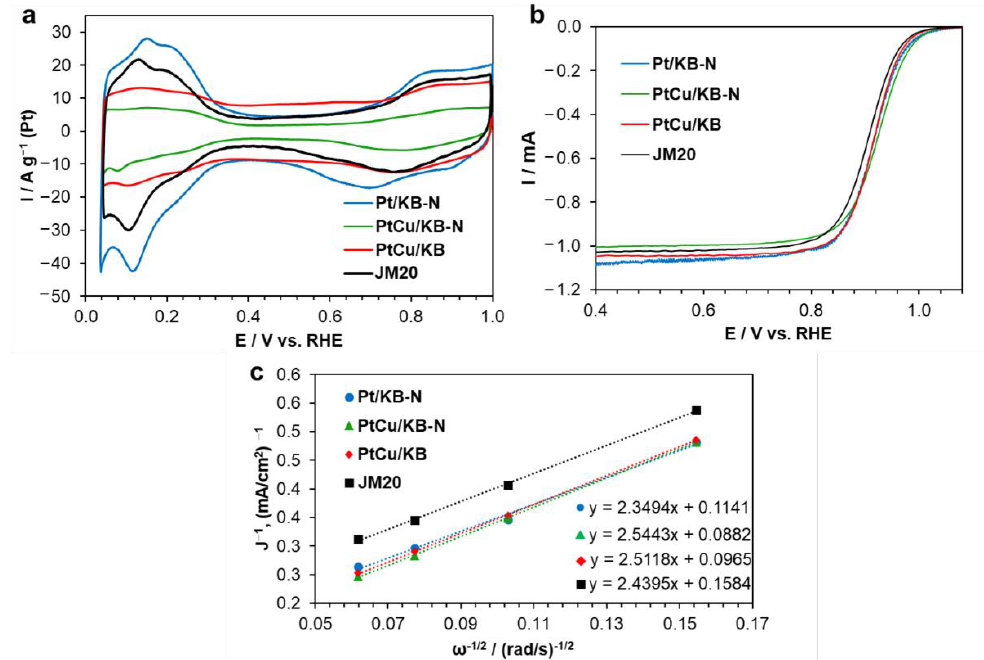
Figure 4. CVs of samples activated in the potential range of 0.04 – 1.00 ( a ). Linear voltammograms of oxygen electroreduction on the studied catalysts at a disk rotation speed of 1600 rpm ( b ). The 1 j −1 dependence of ω −1 /2 at a potential of 0.90 V ( c ); 0.1 M HClO 4 .